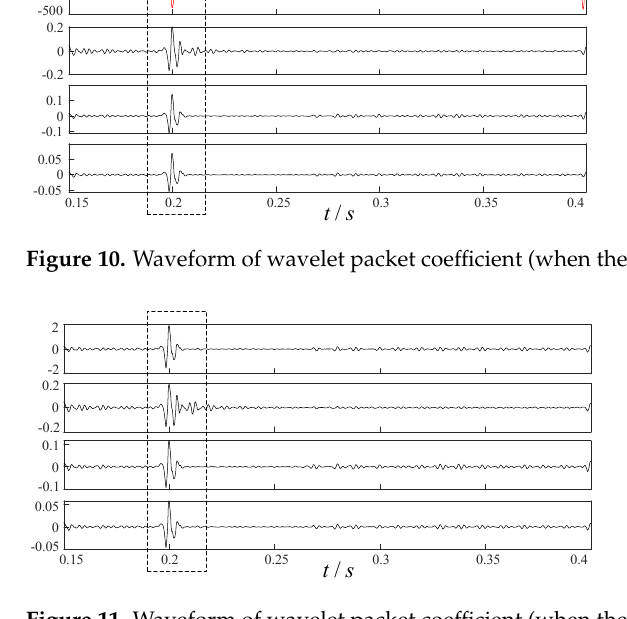
Table 3. Experimental Parameters.